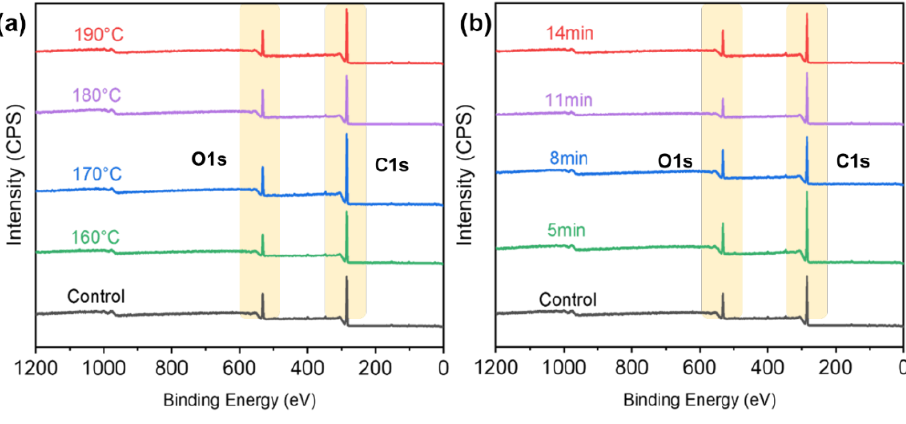
Figure 4. XPS survey spectra of different TPM temperatures ( a ) and durations ( b